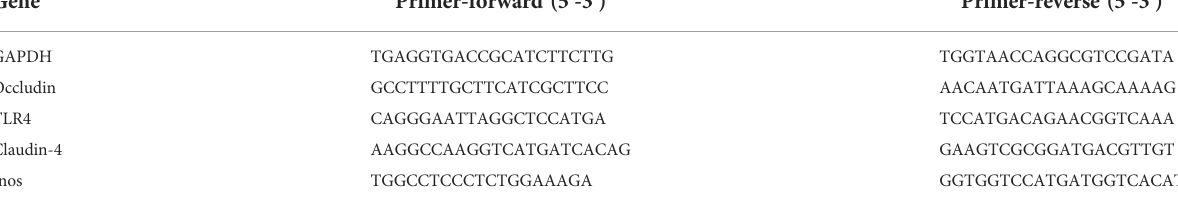
TABLE 1 Sequence of primers for quantitative real-time